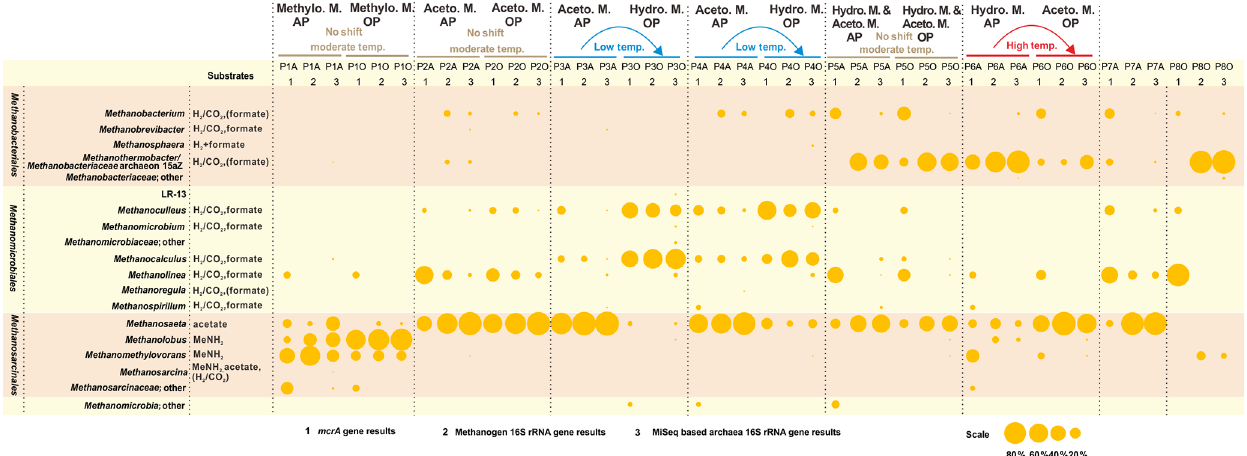
Figure 3. Bubble chart of the proportional composition of methanogens based on MiSeq sequencing results of archaeal 16S rRNA genes and clone sequencing results of the mcrA gene and methanogenic 16S rRNA gene. The major substrate utilization properties originated in Liu and Whitman (2008). MeNH 2 is methylamine and substrates in parentheses refer to being utilized by some but not all species. Methan- othermobacter thermautotrophicus strain Delta H is the phylogenetically closest cultured clone to Methanobacteriaceae archaeon 15aZ. Thus, the combination of Methanothermobacter and the Methanobacteriaceae archaeon 15aZ was used. Methanogenesis shift was based on the transition of major methanogenesis pathway. Abbreviations: Aceto. M., Hydro. M., and Methylo. M. are Acetoclastic methanogenesis, Hydrogenotrophic methanogenesis, and Methylotrophic methanogenesis,